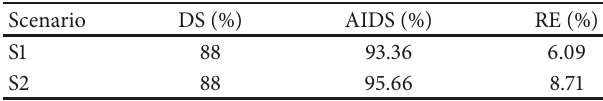
Table 11: The average of identified damage severities based on WPEV and